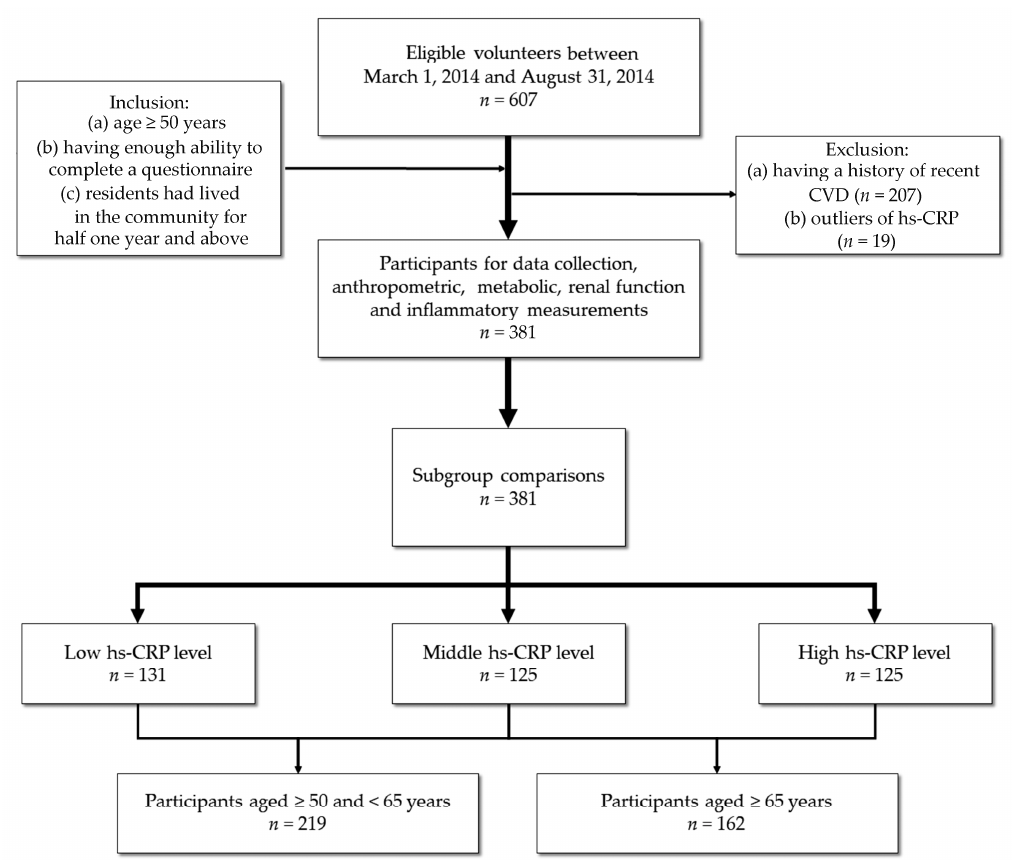
Figure 1. Study flow chart. Initially, we recruited 607 eligible volunteers to participate in a community health promotion project; however, we excluded 11 cases with a history of recent cardiovascular disease (CVD), 19 outliers of high-sensitivity C-reactive protein (hs-CRP) ( > 10 mg / L), and 196 that declined to participate; therefore, we statistically analyzed 381 participants in the present